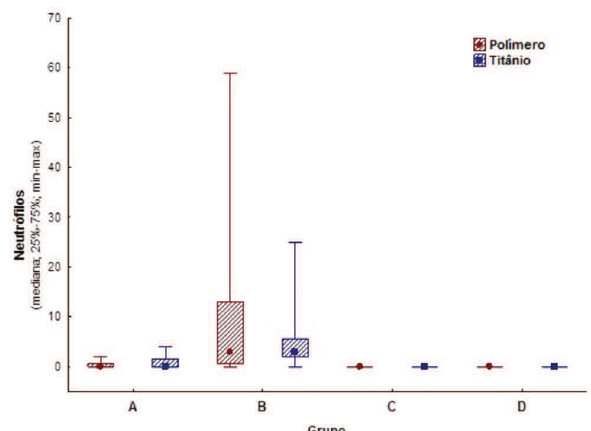
Fig. 2 – Análise quantitativa de linfócitos conforme grupo Fig. 3 – Análise quantitativa de histiócitos conforme grupo definido